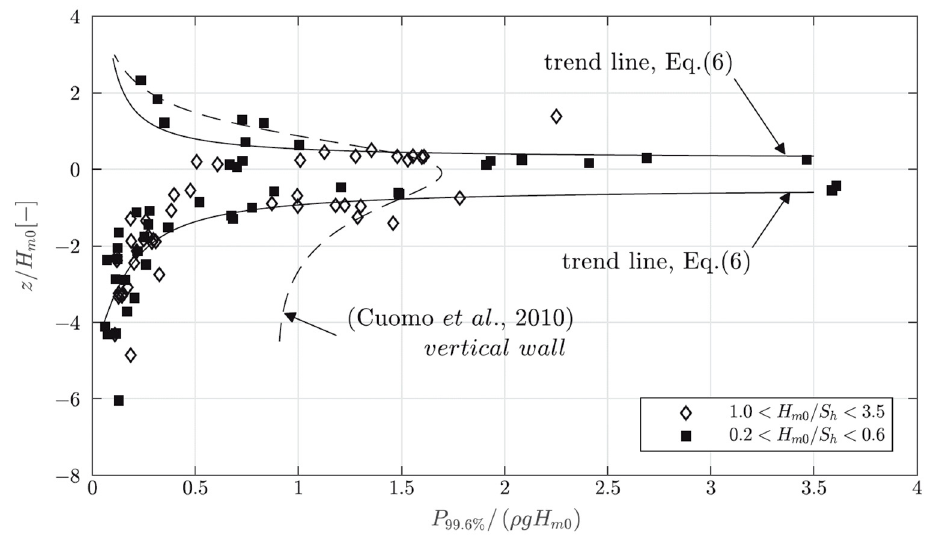
Figure 9. Normalized pressure impact relative to the SWL ( z = 0) for a 1:2 inclined stepped revetment. Table 3. Coefficients a , b, and c for Equation